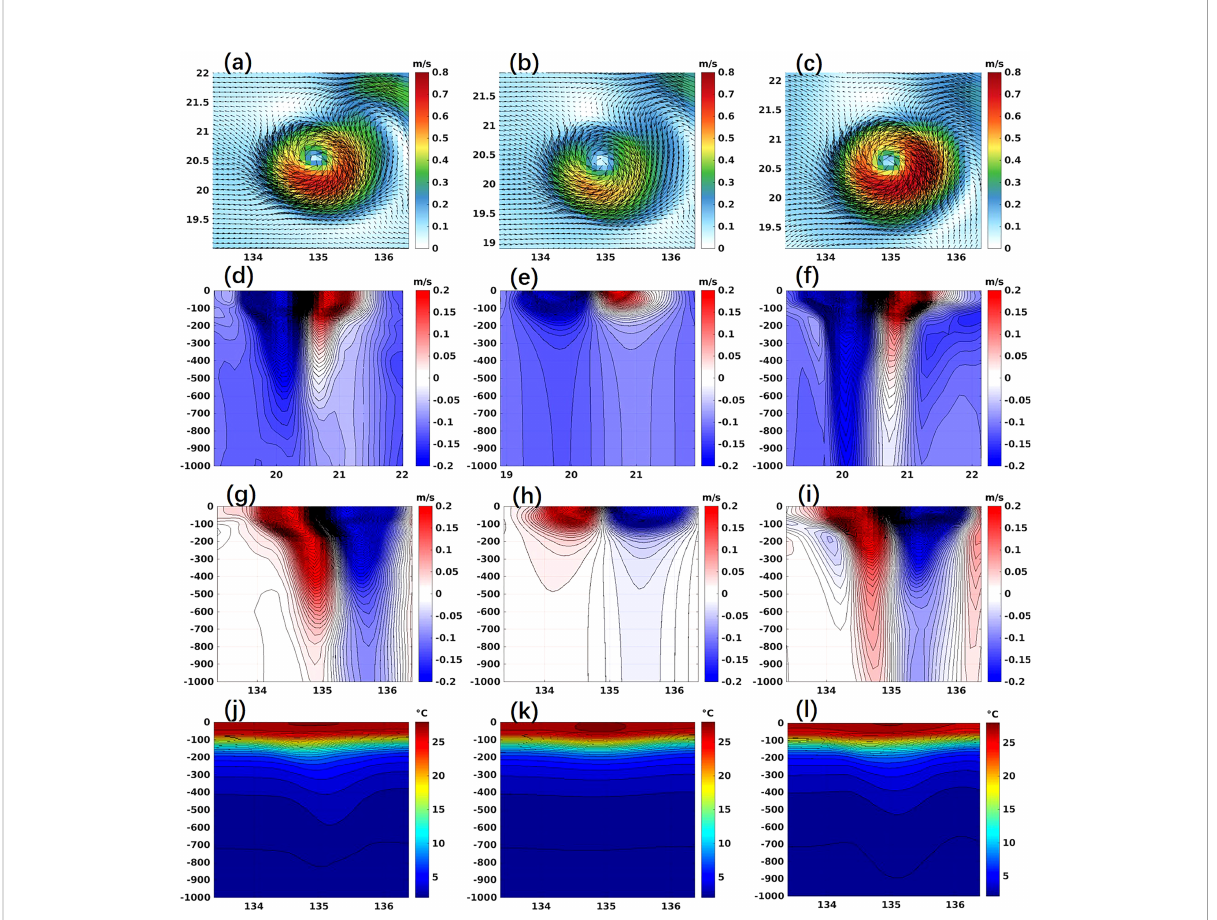
FIGURE 7 The (A – C) sea surface current, eddy center-crossed section of (D – F) u, (G – I) v component of current and (J – L) temperature on 10th prediction day from (A, D, G, J) “ true ” 3D warm eddy, (B, E, H, K) DASLA_W and (C, F, I, L) ED_BOG_W of the idealized experiment, in which the color and arrows in (A – C) represent the current speed and direction, respectively.